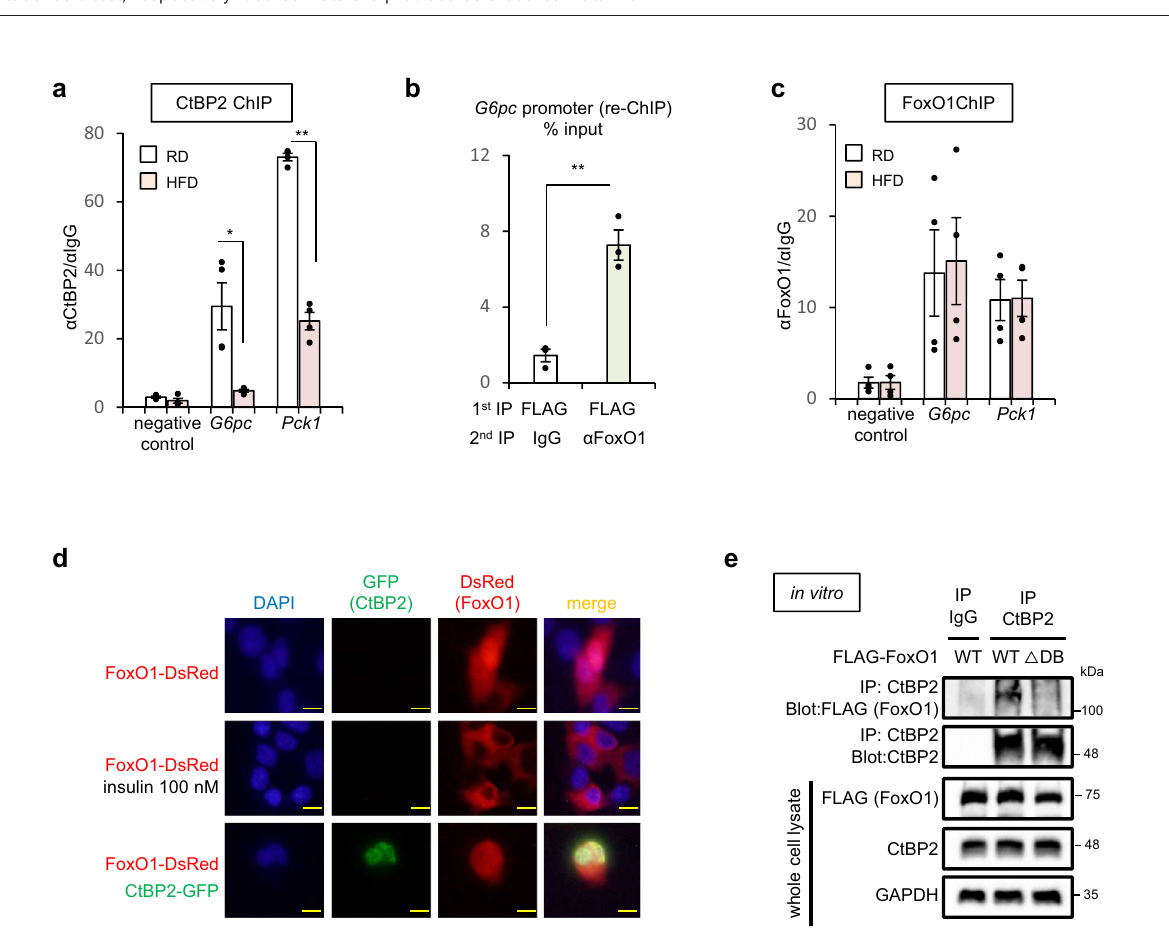
Fig. 3 CtBP2 is markedly inactivated in the liver of obesity. Liver homogenates from mice: a – d , l normal mice, e , h genetically obese mice, f , i diet-induced obese mice (12 – 16 weeks on high-fat diet(HFD), RD: regular diet) and human liver autopsy specimens ( g ) were subjected to co-immunoprecipitation to examine endogenous CtBP2/FoxO1 complex ( a – g ) or CtBP2/SREBP1 complex ( h , i , l , n = 3 or 4 biological independent animals as shown in the blots for each experimental group). The densitometric quanti fi cation is shown to the right of each blot. a – d CtBP2/FoxO1 complex in normal mice in response to either a fasting-feeding cycle ( a 24-h-fasted or fed ad libitum), glucagon ( b 30 min after injection, 200 μ g/kg, 3-h food withdrawal, p = 1.1 × 10 − 3 ), insulin ( c 30 min after injection, 0.4 U/kg, 3-h food withdrawal, p = 6.2 × 10 − 3 ), or glucose ( d 30 min after injection, 2 g/kg, overnight fasted, p = 9.5 × 10 − 3 ). e – i CtBP2/FoxO1 complex in mouse models of obesity ( e , f p = 1.3 × 10 − 5 and 4.1 × 10 − 4 , respectively) or in human obesity (liver autopsy samples. Body mass index (BMI) for each subject was indicated above the blot, g p = 0.022), or CtBP2/SREBP1 complex in mouse models of obesity ( h , i p = 3.9 × 10 − 3 and 0.033, respectively). Mice were fasted for 4 – 6 h. j Primary hepatocytes were treated as in Fig. 1f and gene expression pro fi le was analyzed. k Mutation of the PSDL motif in NR5A2(LRH-1) (Mut: PSDL > PSAS) diminishes CtBP2/NR5A2(LRH-1) interaction in HEK293 cells. l CtBP2/SREBP1 complex in normal liver tissues was diminished by NR5A2(LRH-1) knockdown in vivo (6-h fasted, p = 1.2 × 10 − 3 ). m , n Fatty acyl-CoA content in the nuclei isolated from lean control mice or genetically (ob, m p = 9.3 × 10 − 4 )/diet-induced obese mice (HFD, n p = 0.026) ( n = 6 for lean, n = 4 for ob, n = 5 for RD and HFD, biologically independent animals, 6-h fasted). Data are expressed as the mean ± SEM. * and ** denote p < 0.05 and p < 0.01 evaluated by unpaired two- tailed Student ’ s t -test, respectively. Source Data are provided as a Source Data fi le.